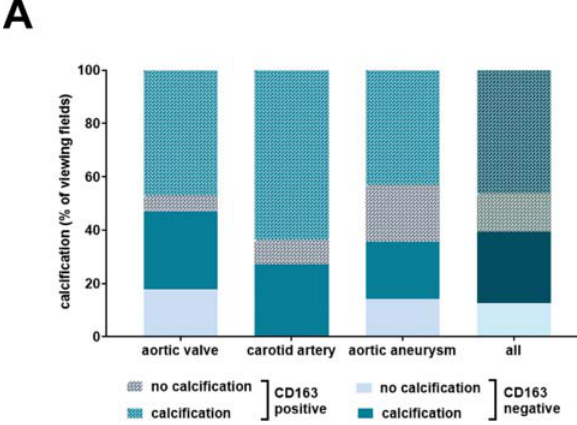
Fig. 7 Colocalization of the hemoglobin scavenger receptor CD163 with calci fi cation in human vascular lesions. ( A ) Results of the quantitative analysis of the colocalization of CD163 and Alizarin S in samples of human stenotic aortic valves, carotid artery plaques and aortic aneurysms. Results are expressed as percentage (%) of the total number of viewing fi elds.